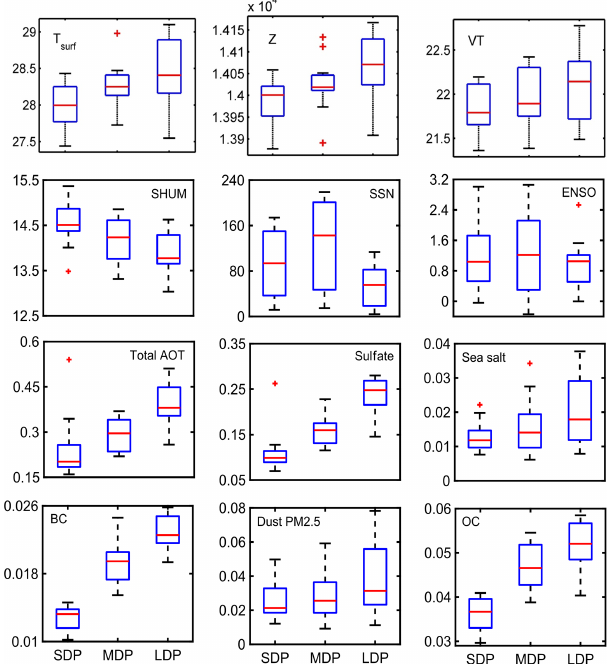
Figure 3. Frequency distribution analysis results of various control- ling factors behind DDF evolution for various types of dry phase lengths over region 1a, namely surface temperature, geopotential, VT, humidity, SSN, ENSO, total aerosols, sulfates, sea salt, BC, dust PM 2 . 5 and